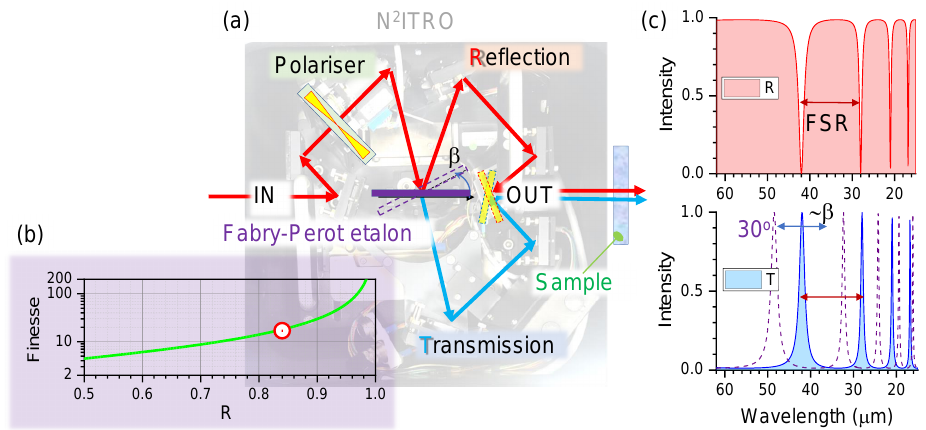
( a ) Concept of T & R spectral analysis at broad and narrow spectral ranges us- ing angular tunable FP etalon (thickness = d / cos β ) at tilt angle β using N 2 ITRO. ( b ) Fi- √ R / ( 1 − R ) where R is the reflectiv- nesse expression for F c > 0.5 is defined as F c ≈ π ity of Kapton/vacuum surface. In experiments, the finesse was F c ≈ 17, i.e., R = 84% (a dot-marker). ( c ) The T , R spectra calculated for d = 25 µ m and refractive index n = 1.68 as in experiments with Kapton FP etalon; reflectivity was taken as R = 0.8. Transmittance spectra at tilt angle of FP etalon cos β ≡ cos30 ◦ is shown. Note, FSR is not equally spaced in wavelength and equally spaced in energy (or wavenumber ˜ ν ) since λ ∝ 1/ ν